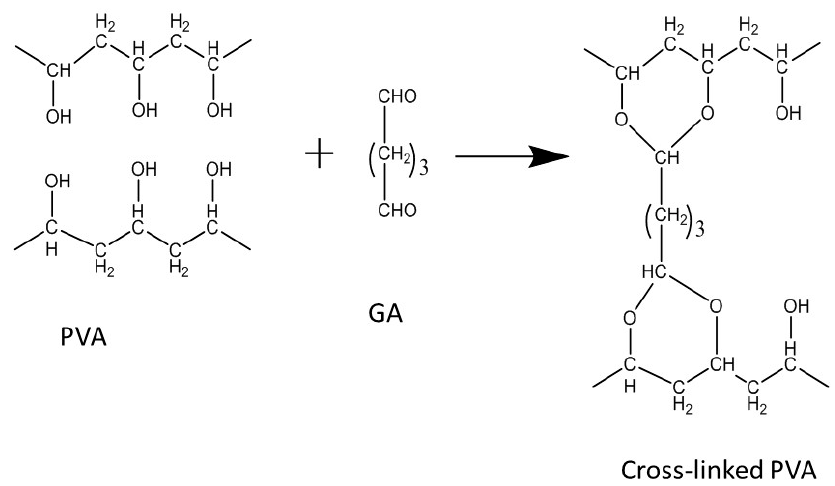
Figure 4. Crosslinking of PVA using GA.